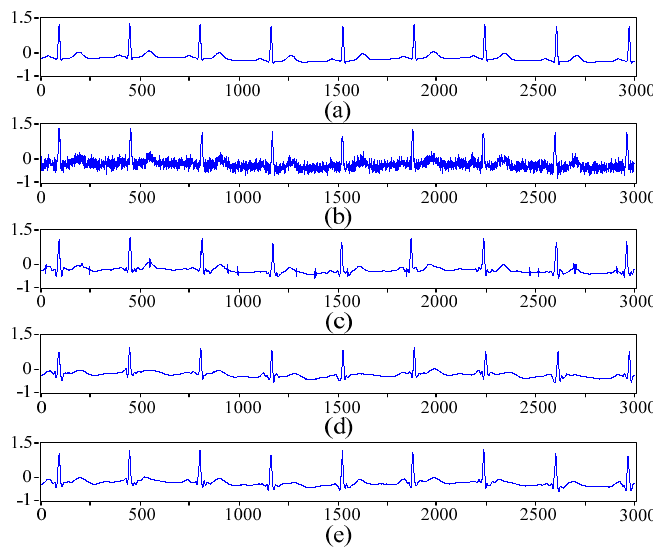
Figure 3. Denoising results of different threshold functions. ( a ) Original signal; ( b ) Noisy signal; ( c ) Signal denoised by the soft threshold function; ( d ) Signal denoised by the hard threshold function; and ( e ) Signal denoised by the improved threshold function.